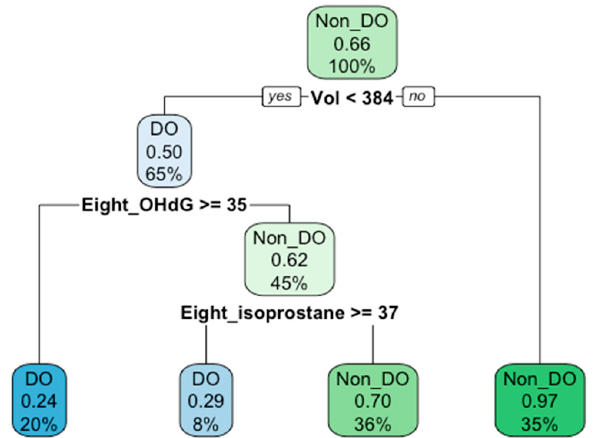
Figure 2. The decision tree model for distinguishing DO patients from non-DO patients with USI. The root node comprises voided volume (Vol) and the inner nodes include 8-OHdG (presented as Eight_OHdG) and 8-isoprostane (presented as Eight_isoprostane). Decimal numbers in the middle of each node represent the ratio of non-DO data split by the node in the training model. Percentage numbers at the bottom of each node represent the percentage for which the data in the node account in the training model. The accuracy of the training model and internal validation was 80.72% and 81.72%, respectively. DO: detrusor overactivity; Non_DO, Non-DO; Vol, voided volume; Eight_OHdG, 8-hydroxy-2-deoxyguanosine; Eight_isoprostane, 8-isoprostane.